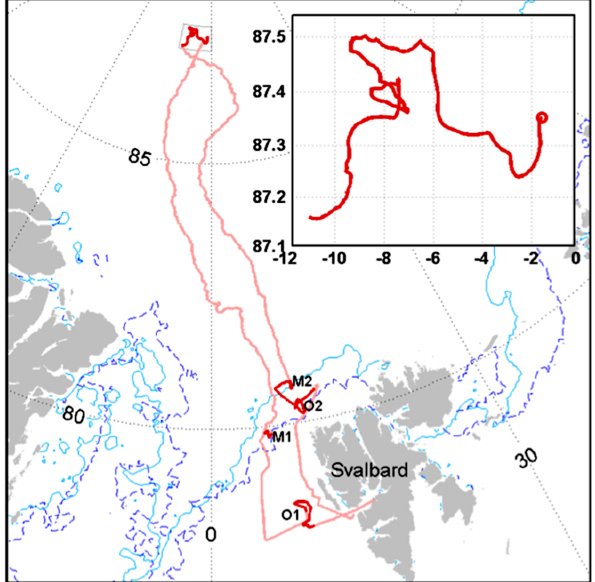
Figure 1. Track of the icebreaker Oden in the Arctic (pink). The path during the ice drift is shown in the insert (red line). The circle indicates the start of the ice drift; the ice edge (thin blue line) was passed on 12 August